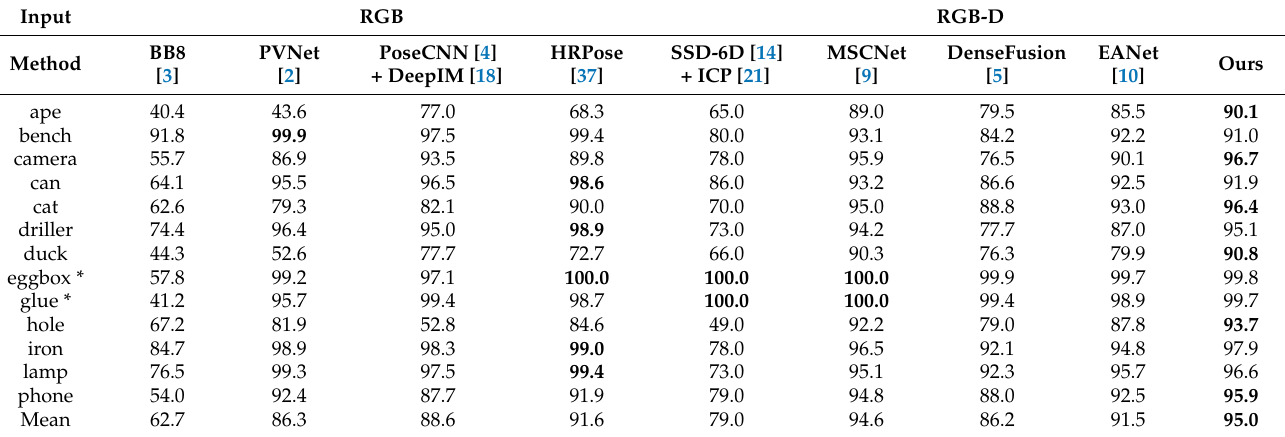
Table 1. Quantitative evaluation results on the LineMOD Dataset using the ADD-(S) metric, where the data shown in bold are the highest scores among different methods, and the objects marked with an asterisk * are symmetrical objects.